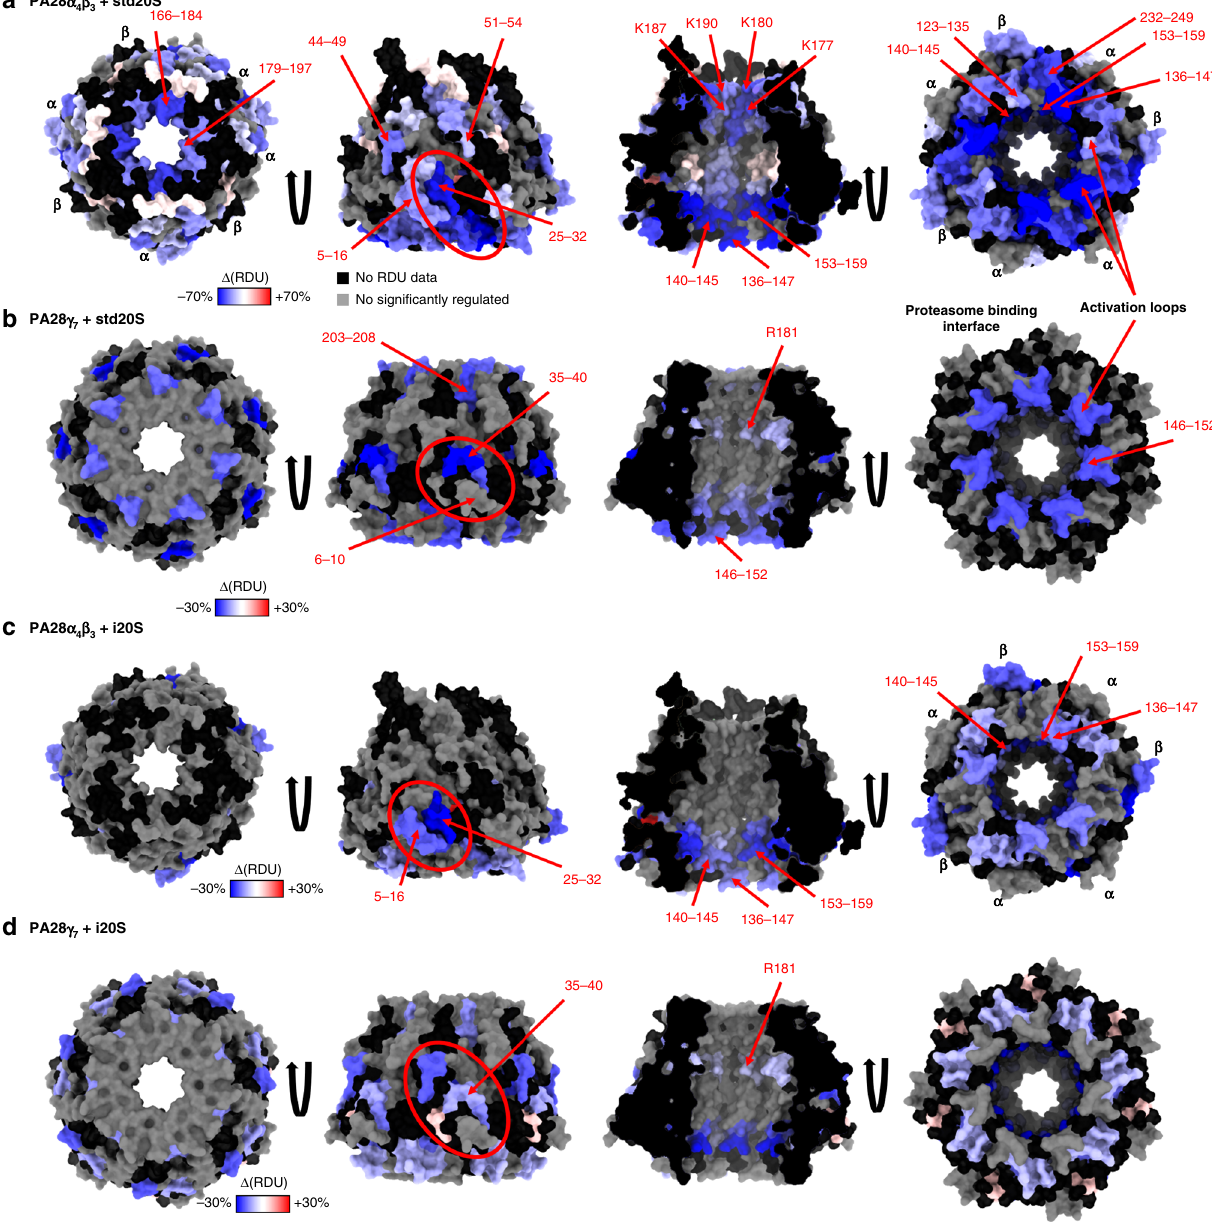
Fig. 6 Activation of PA28 αβ and PA28 γ by the 20S involves a rearrangement of the N-ter kink and an allosteric change. The sum of differential RDUs accumulated from 0.5 to 30 min deuteration of the PA28 regulators alone or in presence of the 20S proteasome ( Δ (RDU) = RDU PA28/20S − RDU PA28 ) is color coded from blue (less accessible in the complex) to red (more accessible in the complex) and ranges from − 70%/ + 70% for PA28 αβ + std20S ( a ) and − 30%/ + 30% for PA28 γ + std20S ( b ) PA28 αβ + i20S ( c ) and PA28 γ + i20S ( d ). The heptameric complexes PA28 α 4 β 3 ( a and c PDB: 5MX5) and PA28 γ 7 ( b and d homology model) are viewed from the top (left), front and inside (middle), and bottom (right). Residues of PA28 that present a signi fi cant decrease of deuteration upon binding of the 20S proteasome are located around the N-ter kink (red ovals), the activation loop and 20S interface and the entry of the channel (left). Residues in gray were not considered signi fi cantly different according to the statistical thresholds presented in Fig. 1c. Residues with no RDU information in one or both conditions are in black. Δ (RDU) sum of differences of relative deuterium We compared the effect of PA28 αβ binding to the std20S (Fig. 7a – e) with the other conditions (Fig. 7f – t). Although the destabilization of the α -ring N-ter by PA28 αβ was almost complete in the std20S (except α 6) (Fig. 7a, large red circle), it was restricted to α 2/3/7 in the i20S (Fig. 7k, large red circle), suggesting a partial opening of the pore. Binding of PA28 γ did not affect any of the std20S α subunit N-ter (Fig. 7f) and only the i20S α 2 and α 7 N-ter (Fig. 7p, large red circle), indicating less PA28 γ -driven opening of the std20S than the i20S pore.